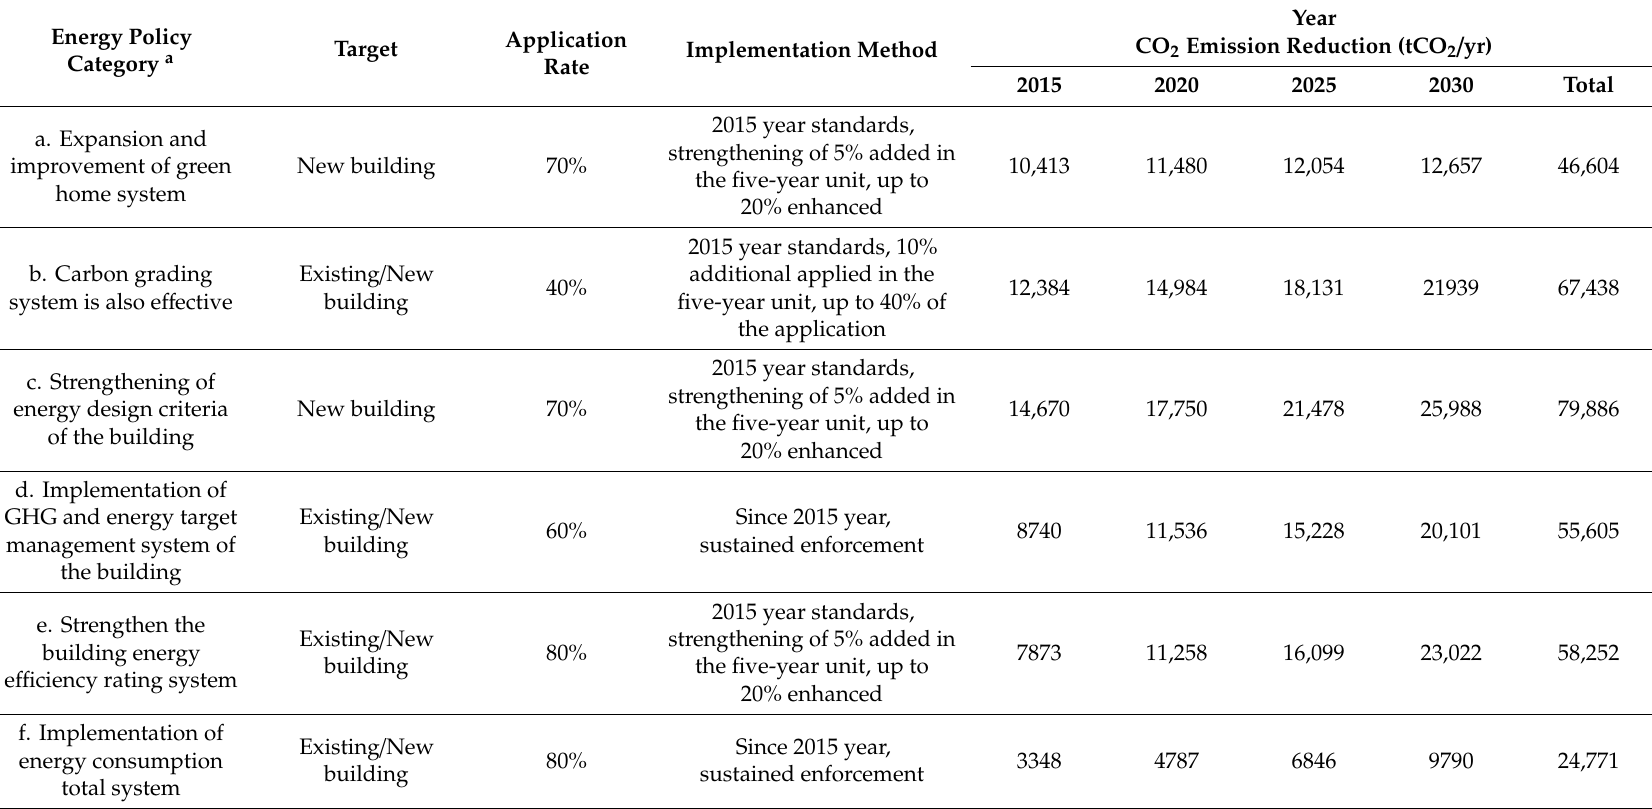
Table 6. The results of the evaluation methods and CO 2 reduction of the step-by-step BEP